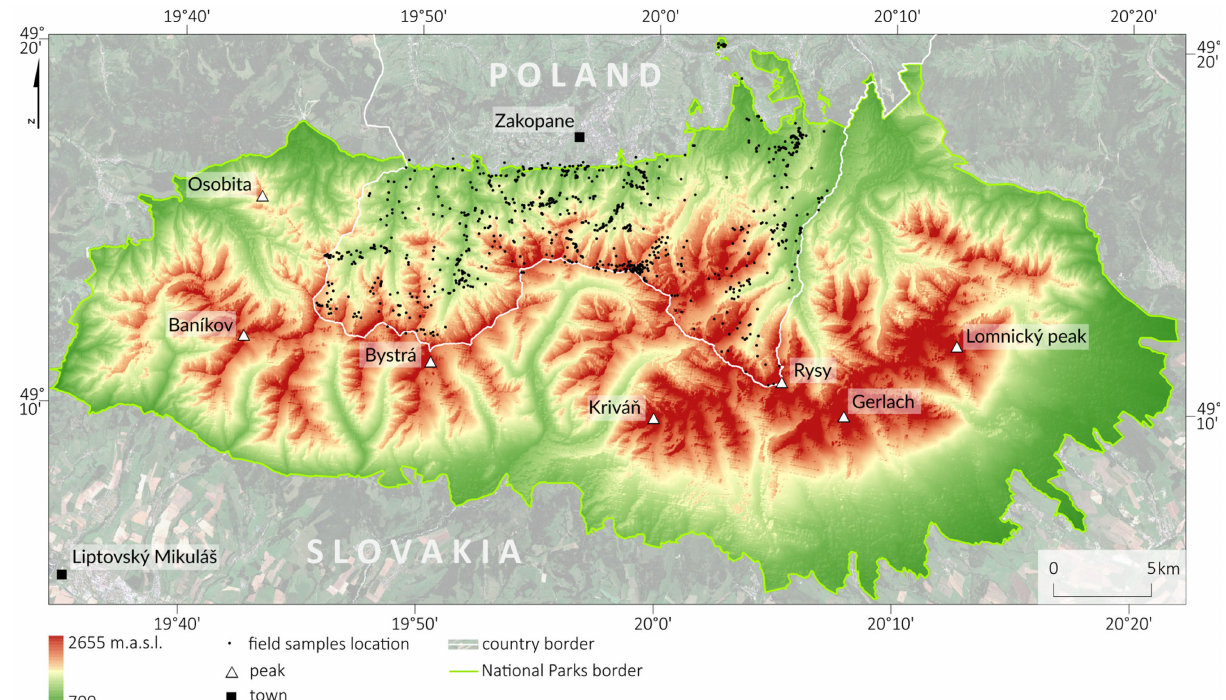
Figure 5. Location of polygons acquired during field campaigns (digital elevation model source: Shuttle Radar Topography Mission, NASA; background image: Sentinel-2 RGB composition 21 July 2022,